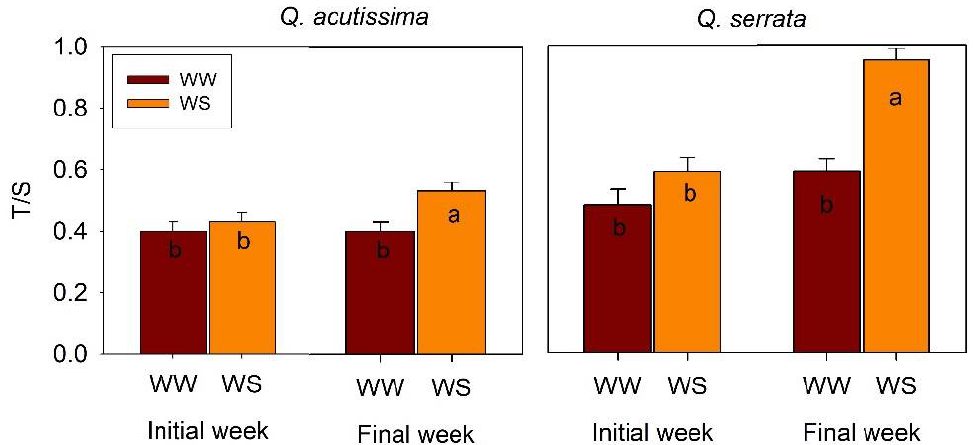
Figure 2. Trichome-to-stomata ratio (T/S) of Quercus acutissima and Q. serrata in well-watered (WW) and water-deficit stress (WS) treatments. Vertical bars indicate the SE (n = 10). Comparison means derived using Tukey’s test ( p < 0.05) are shown for the significant interaction between water stress and time. Different lowercase letters indicate significant differences.